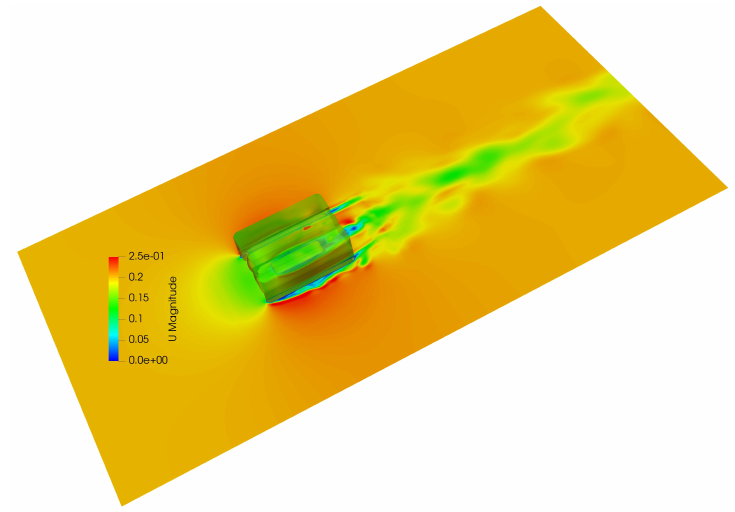
Figure 10. The interactions between flows generated by different parts of the vehicle. The instantaneous velocity field of the vehicle under the yaw motion is demonstrated in Figure 11. Three sets of individual vortex shedding are formed at the rear of the vehicle, but due to the inlet flow direction is not aligned with the vehicle movement direction in the rotational motion, the interactions between the three sets of the shedding are not as strong as that in the translational motion.